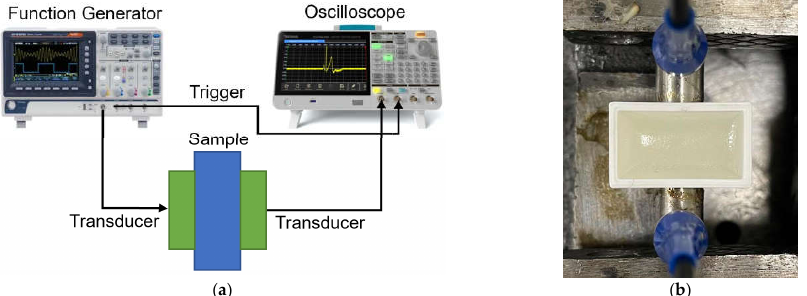
Figure 1. ( a ) Diagram of the ultrasonics instrumentation and sample setup; ( b ) picture of an adhesive sample while being tested during curing.